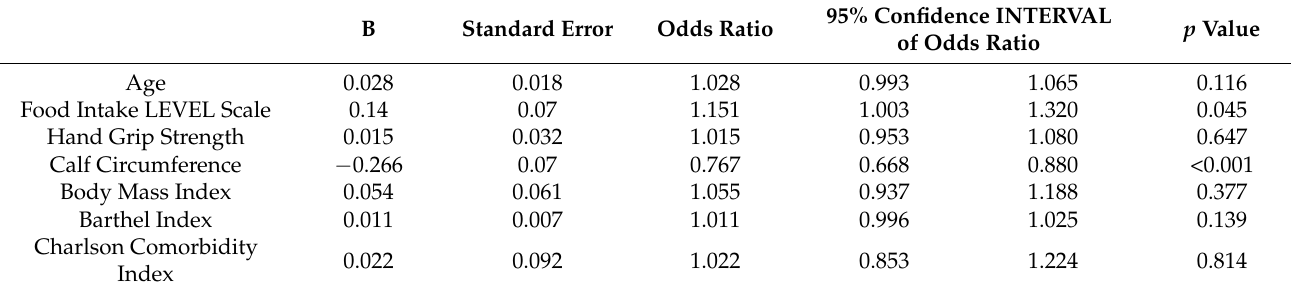
Table 3. Logistic regression analysis of sarcopenic dysphagia (females).